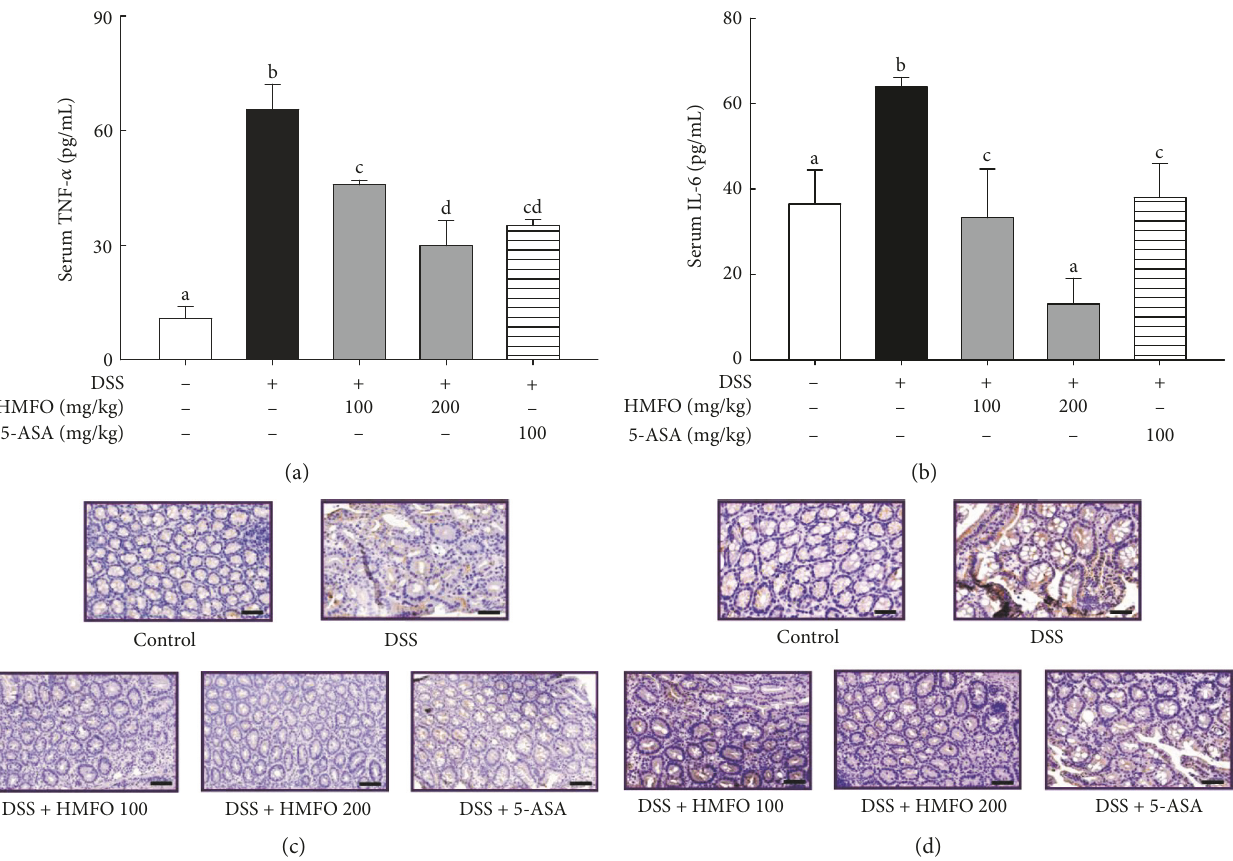
Figure 3: E ff ects of HMFO on serum levels and immunohistochemical staining for proin fl ammatory cytokines. (a) TNF- α production in mouse sera on day 10. (b) IL-6 production in mouse sera on day 10. Immunohistochemical staining of TNF- α (c) and IL-6 (d) in colonic tissue ( × 40, scale bar =50 μ m). Brown staining indicates TNF- α (c) and IL-6 (d) positivity, respectively. Values with di ff erent letters are signi fi cantly di ff erent ( p < 0 05 ). 5-ASA, 5-aminosalicylic acid (100mg/kg); DSS, dextran sulfate sodium; HMFO, polysaccharides of Cynanchum wilfordii (100 or 200